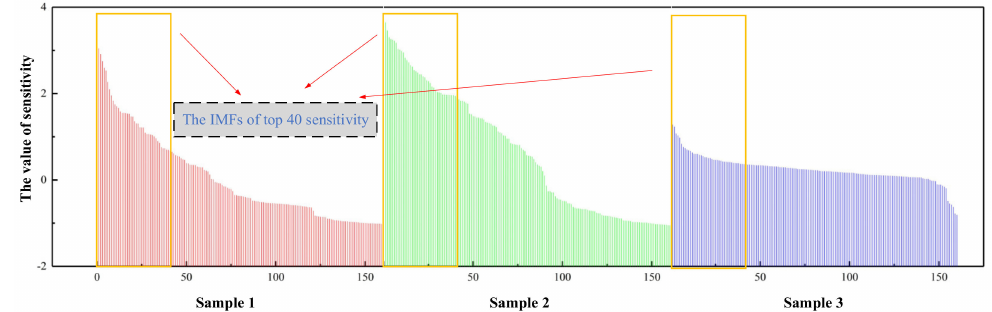
Figure 8. Sensitivity ranking of IMFs for the three samples. The x -axis is the number of IMFs of each sample and the y -axis is the sensitivity value of each